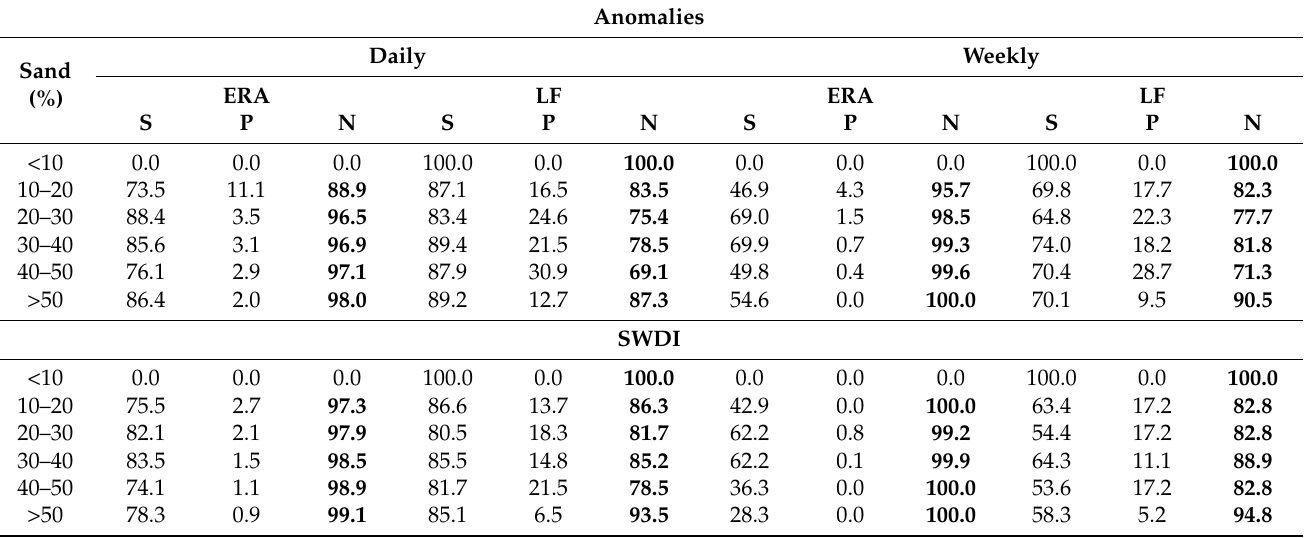
Table 5. Percentage of significant (S), positive (P), and negative (N) trends at daily and weekly scales and by the sand content interval. Maximum trend percentage values are in